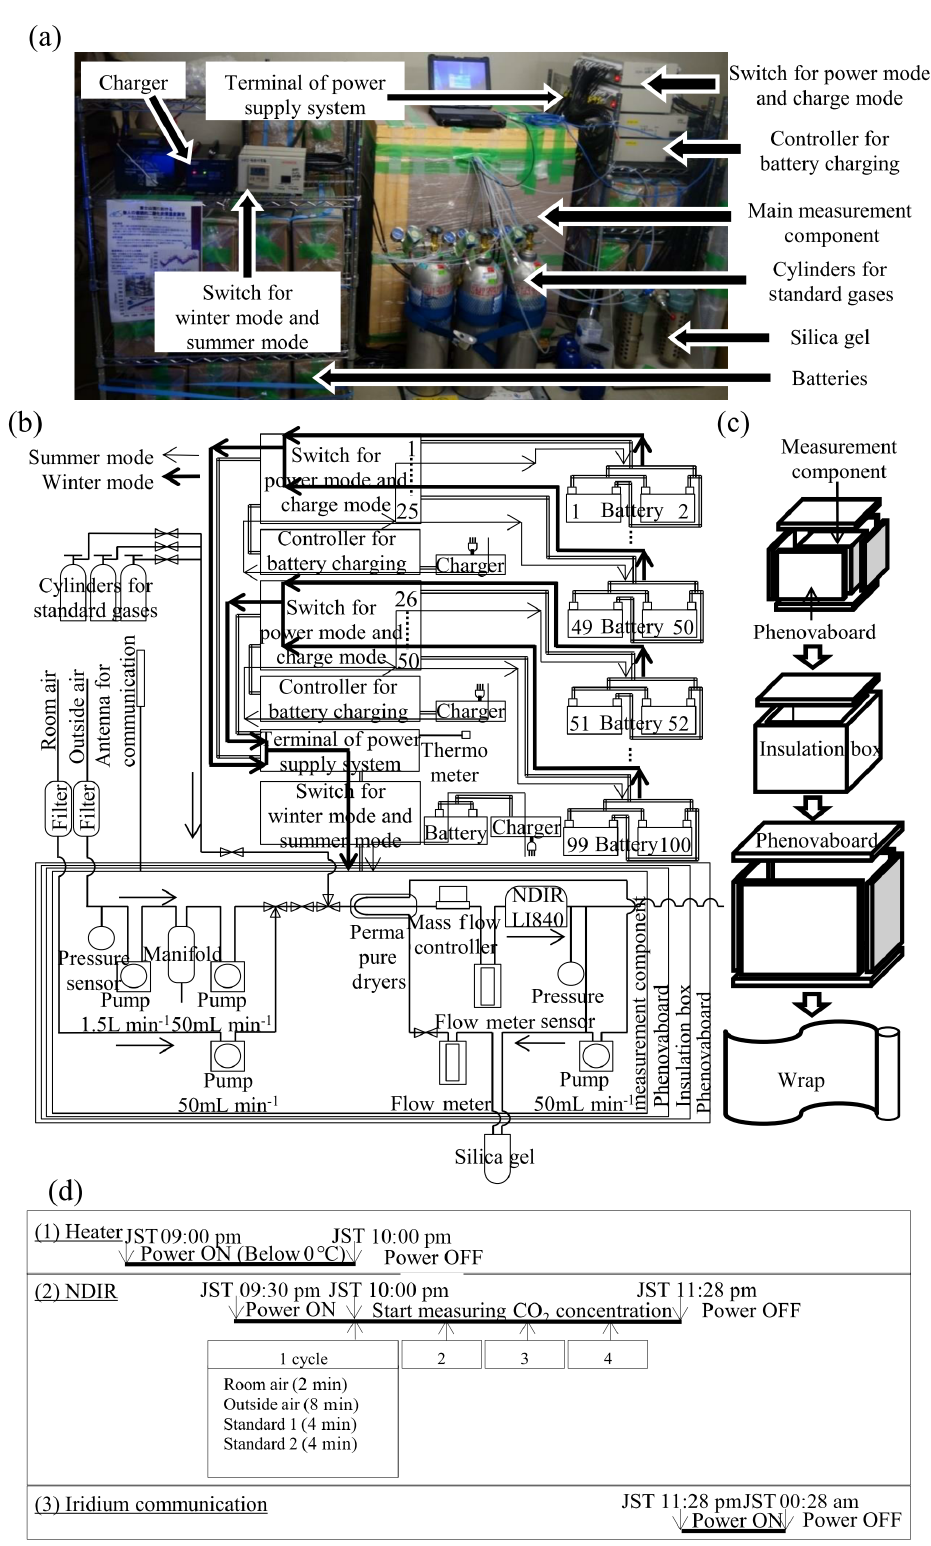
Figure 2. The CO 2 measurement system: (a) picture of the system installed in the third building at the Mt. Fuji station, (b) schematic of gas and electricity flows. The thin lines and arrows show the direction of electric current in the summer mode, and the thick lines and arrows show it in the winter mode. (c) Insulation method used for the main measurement component, and (d) measurement